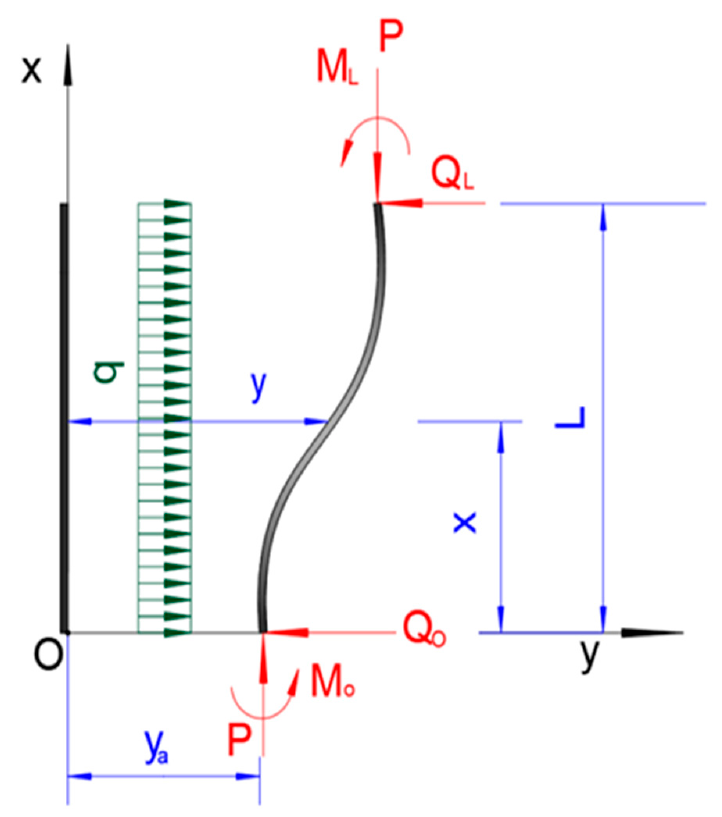
Figure 2. The force diagram of the compression rod.